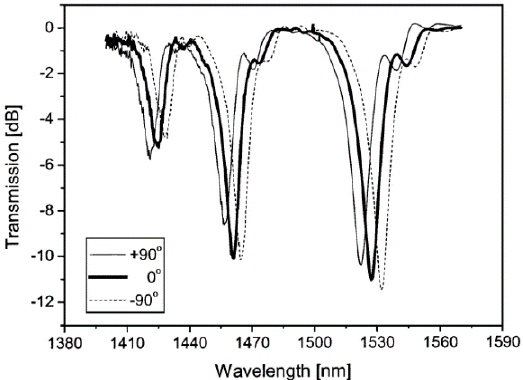
Figure 16. Transmission spectra of a fabricated HLPG under three twisted angles, where the thick solid curve represents the case with the zero torsion applied, whereas the thin solid and the dotted curves denotes the cases with +90 degree of co-directional torsion and − 90 degree of contra-directional torsion, respectively applied on the HLPG. Adapted with permission from Ref. [17] © The Optical Society.